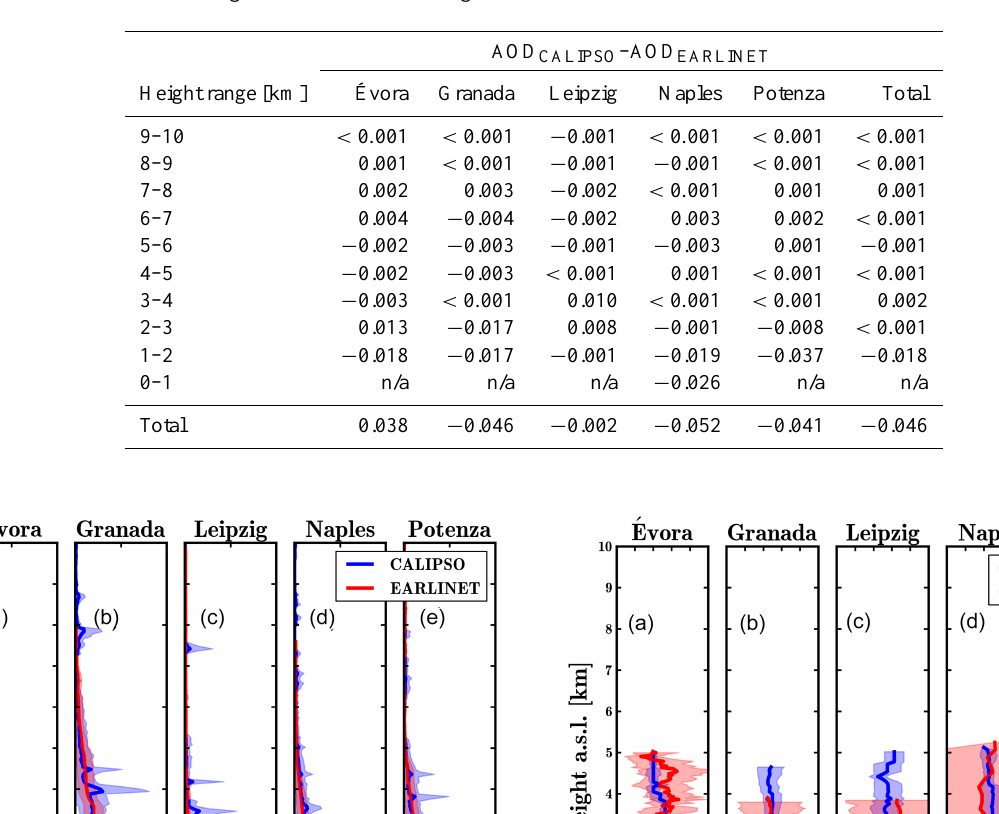
Table 4. AOD differences in the range 0–10km over 1km height intervals for the five EARLINET stations.